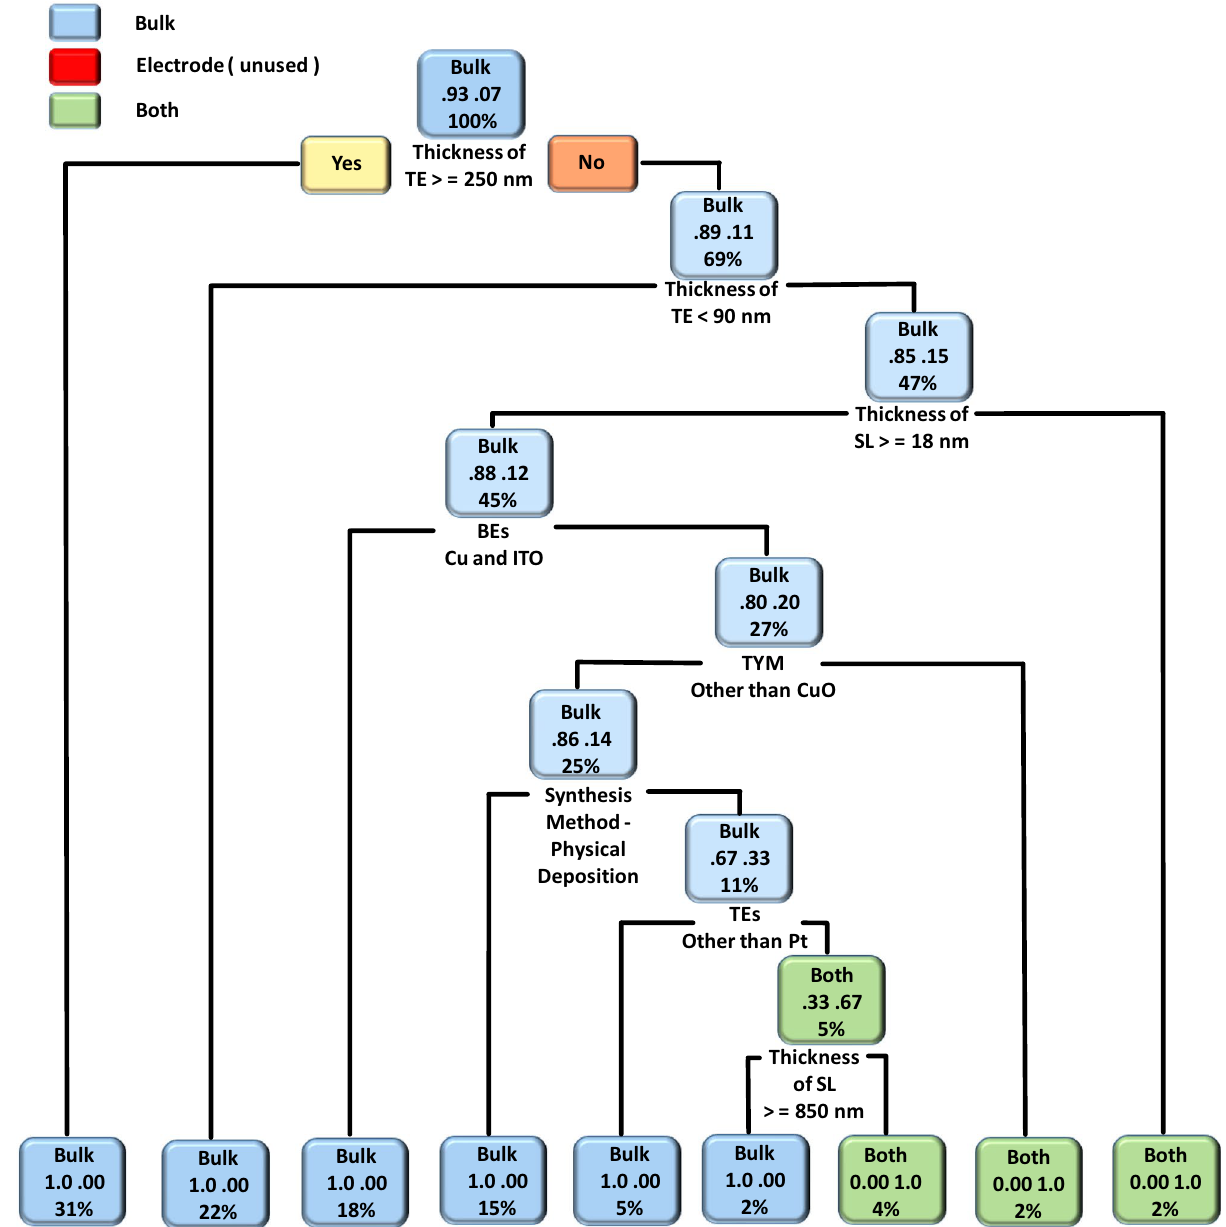
Figure 5. The DT model of the type of conduction mechanism (bulk limited, electrode limited, or both). The present model suggests an impact of device fabrication parameters on the type conduction mechanism of copper oxide-based RS